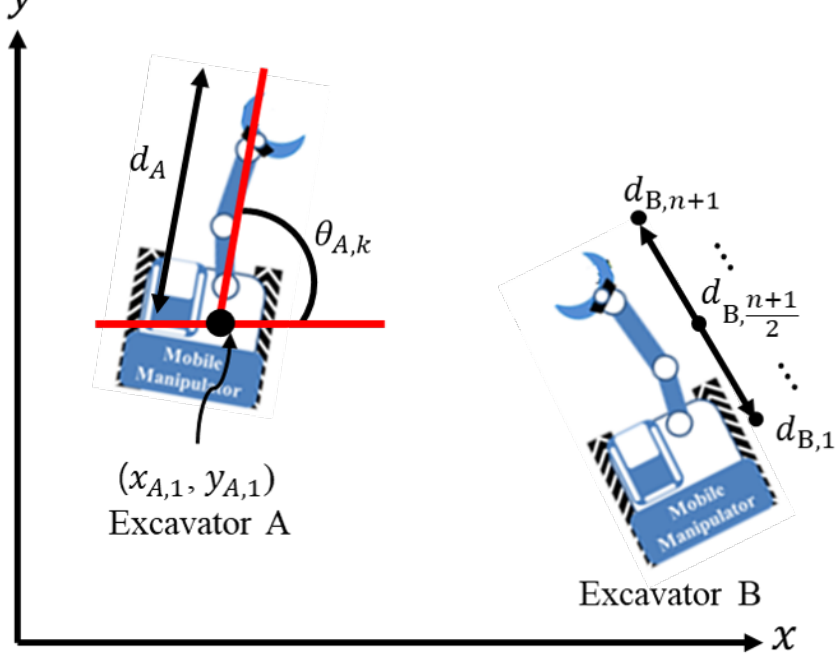
Figure 1. Top view: Two excavators are arranged. θ ( A , m ) , d ( B , n ) , and ( x A ,0 , y A ,0 ) are